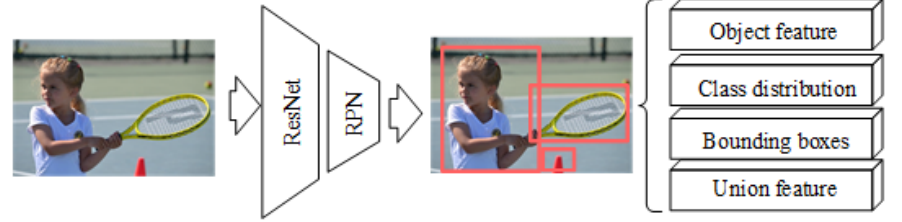
Figure 3. Structure of the feature extraction module.